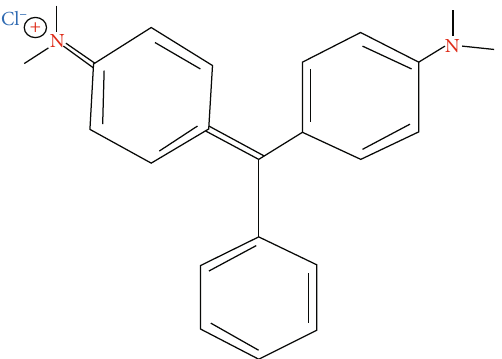
Figure 1: The molecular structure of MG was adopted and redrawn from